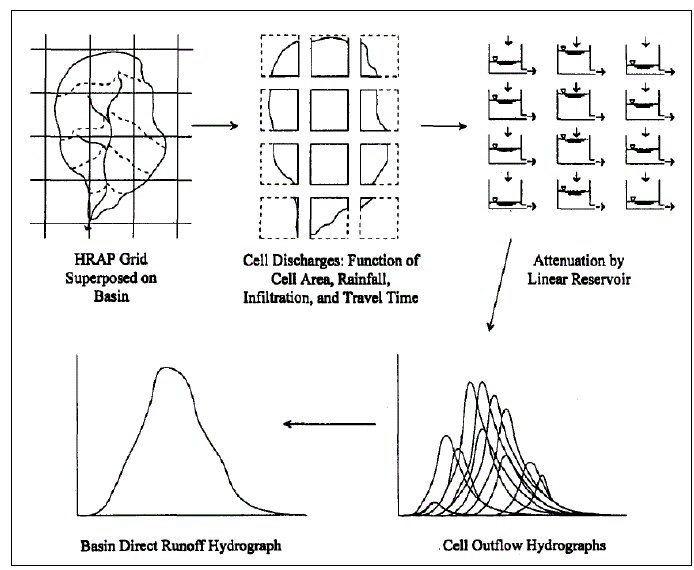
Figure 5. ModClark model’s conceptual structure; adopted from [44].